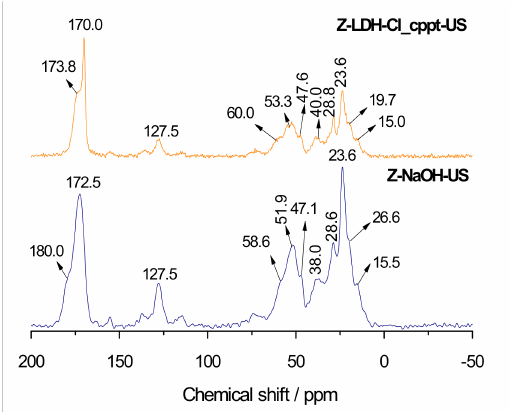
Figure 6. Solid state 13 C NMR spectra of Z-NaOH-US and the Z-LDH-Cl_cppt-US